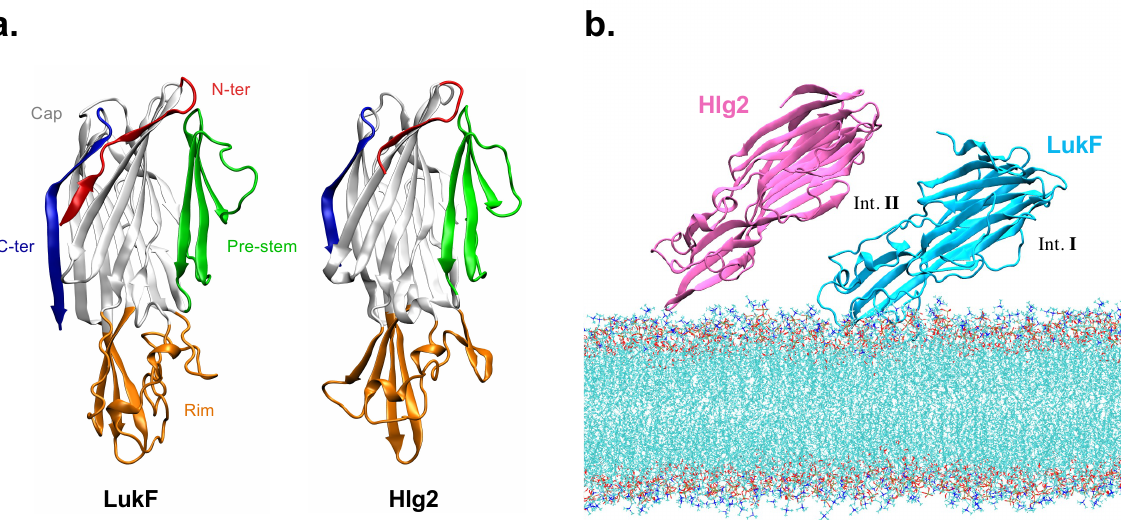
Figure 1. ( a ) Graphical representation of LukF and Hlg2 structures in the monomeric form. Different colors are used to distinguish the functional domains. ( b ) Starting configuration employed in the simulations. Hlg2 is placed in proximity of interface II (int. II) of LukF, the one exposing the N-ter, at a distance larger than the cutoff used for the non-bonded